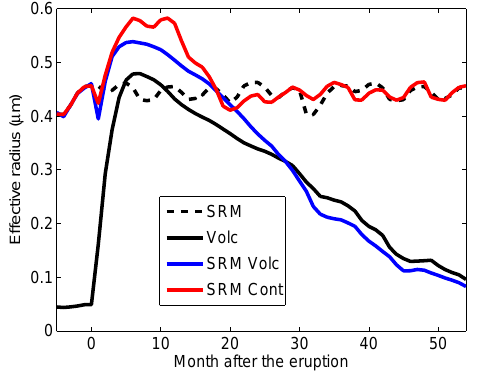
Figure 3. Mean effective radius in the different scenarios between 20 ◦ N and 20 ◦ S latitudes and between 20 and 25km altitude